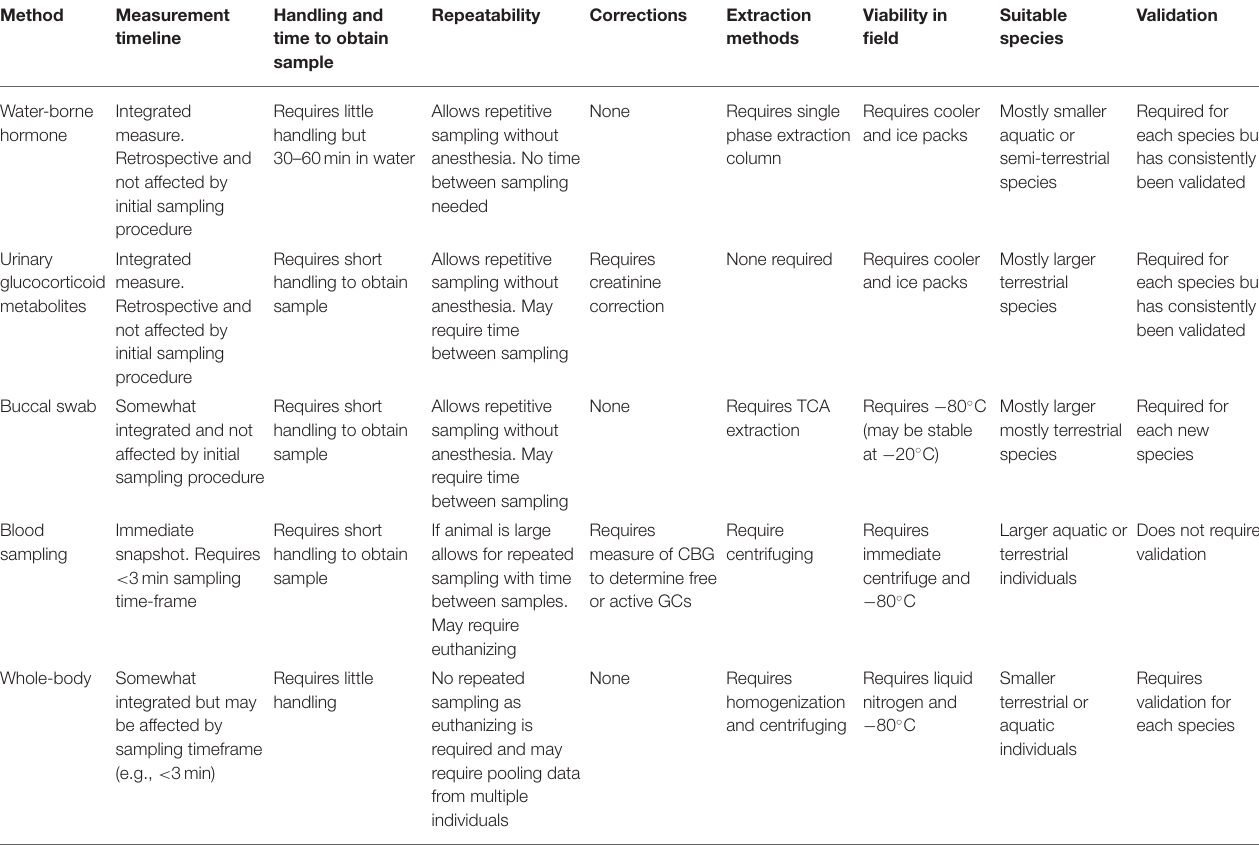
TABLE 1 | Comparison of non-invasive and traditional methods of corticosterone measurement in amphibians.